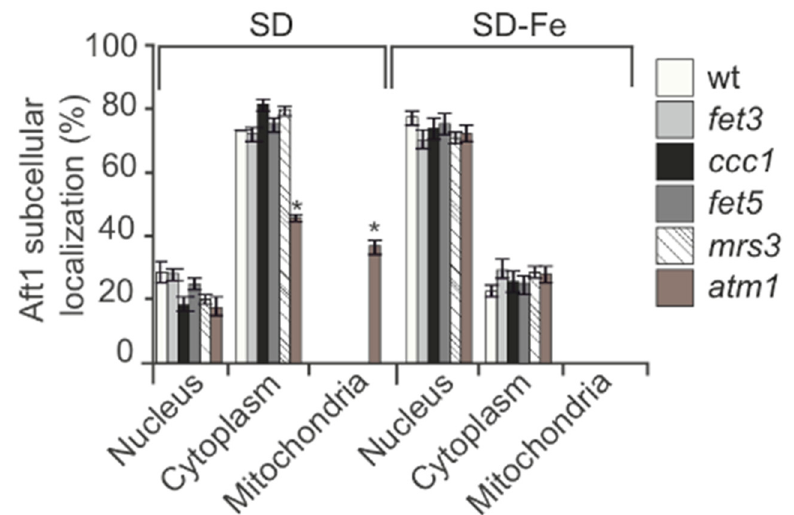
Figure 3. Iron accumulation in organelles do not determine Aft1 localization upon iron depletion. wt, fet3, ccc1, fet5, mrs3 and atm1 mutants were transformed with pAft1GFP and grown to the log phase in SD or SD-Fe media with amino acids at 30 ◦ C. Samples were collected for in vivo observation in the fluorescence microscope. * 0.05 > p > 0.01.